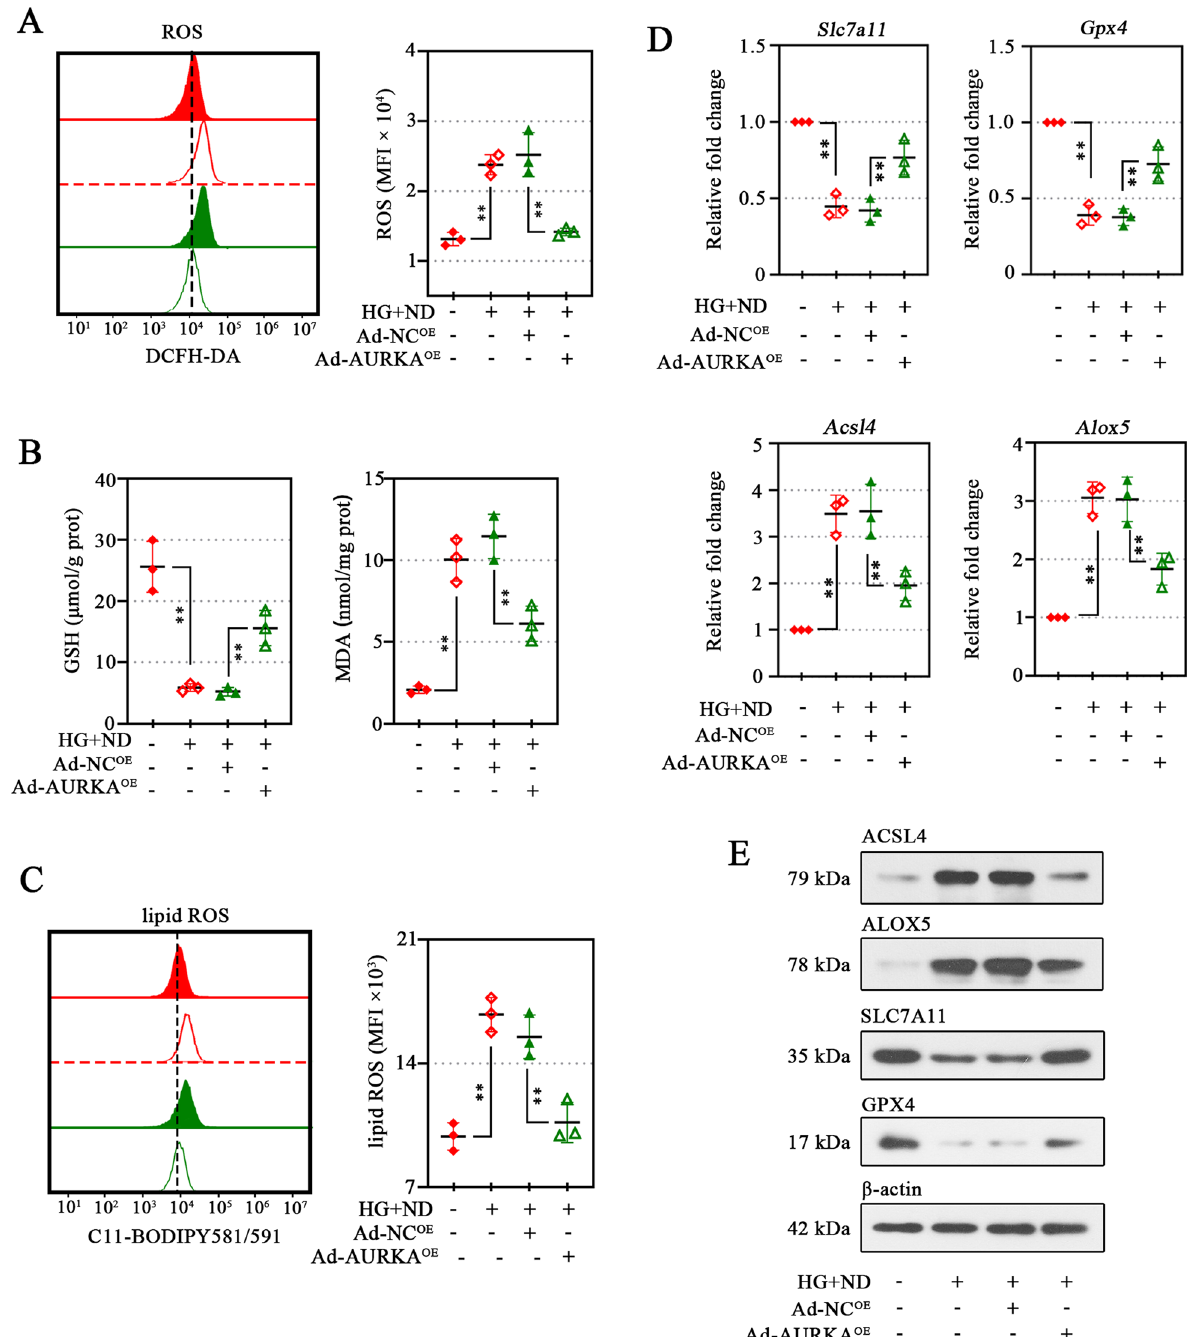
Fig. 4 AURKA overexpression protects cells against oxidative stress upon high glucose and nutrient deprivation stimulation. Detection of ROS production in HMEC-1 cells using the ROS-specific fluorescent probe 2,7-dichlorodihydrofluorescein diacetate (DCFH-DA) ( A , left), and quantification of fluorescence intensities in indicated cells was displayed on the right ( A ). MFI, Mean fluorescence intensity. Relative levels of glutathione (GSH) ( B ) and malondialdehyde (MDA) ( B ) were examined in the cells. Detection of ROS production in HMEC-1 cells using the lipid ROS-specific fluorescent probe C11-BODIPY 581/591 and quantification of fluorescence intensities in indicated cells was displayed on the right ( C ). RT-qPCR ( D ) and Western blot ( E ) showed the levels of Solute Carrier Family 7 Member 11 (SLC7A11), Glutathione Peroxidase 4 (GPX4), Acyl-CoA Synthetase Long Chain Family Member 4 (ACSL4), and Arachidonate 5-Lipoxygenase (ALOX5) in indicated cells. Data were represented as mean SD. ** P < 0.01. Each dot indicated a biological replicate, n ± =